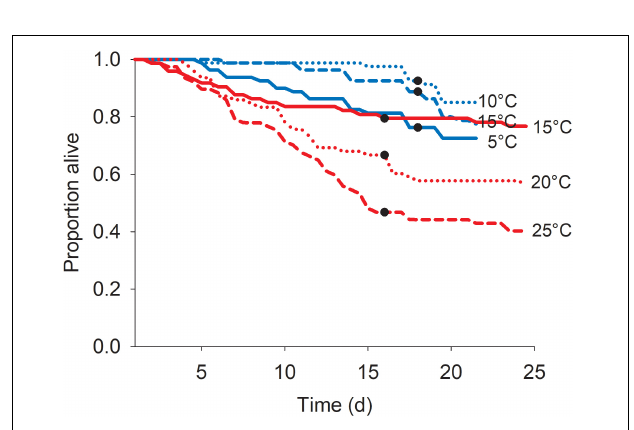
FIGURE 5 | Survival of zebra mussels, Dreissena polymorpha , in control treatments at the various acclimatization temperatures for the cold (blue lines) and warm (red lines) blocks. Values represent the proportion of the total individuals alive over time out of 80 individuals (2 runs × 2 replicates × 20 individuals). Dots show the moment when the shortest of the two runs